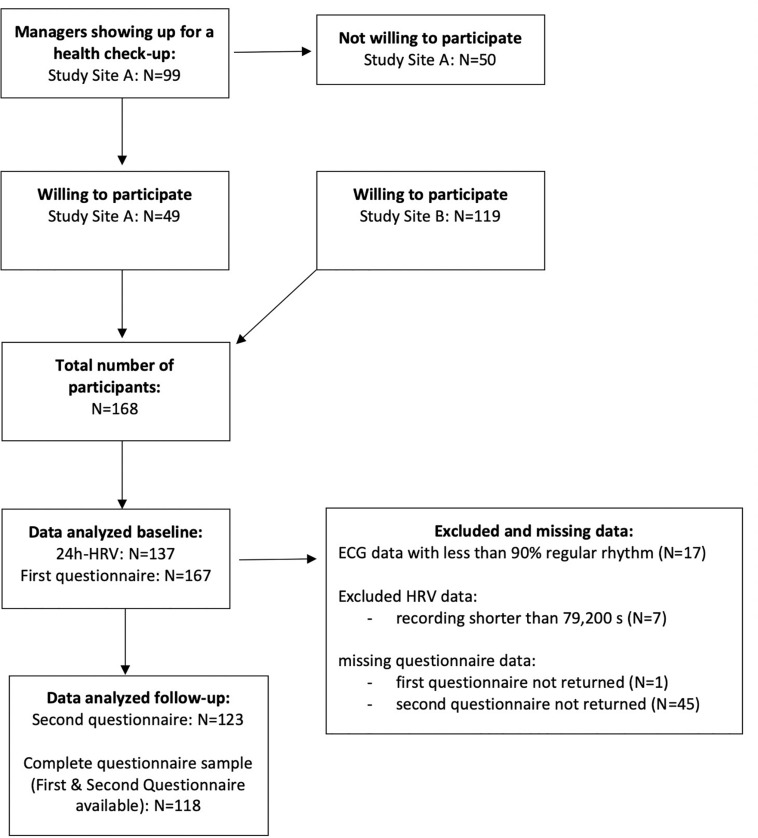
Flowchart of recruitment.